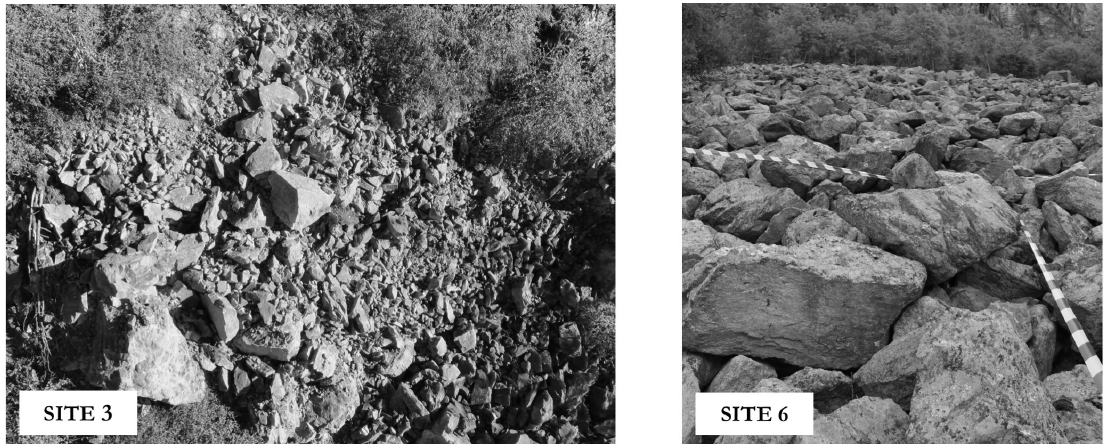
Figure 2. Views of the test sites No.3 and No.6 for the determination of the parameter α . Test site No.3 is characterised by an heterogeneous deposit in terms of block sizes, resulting in α = 0.746. Test site No.6 is characterised by a quite homogeneous deposit in terms of block sizes, resulting in α =